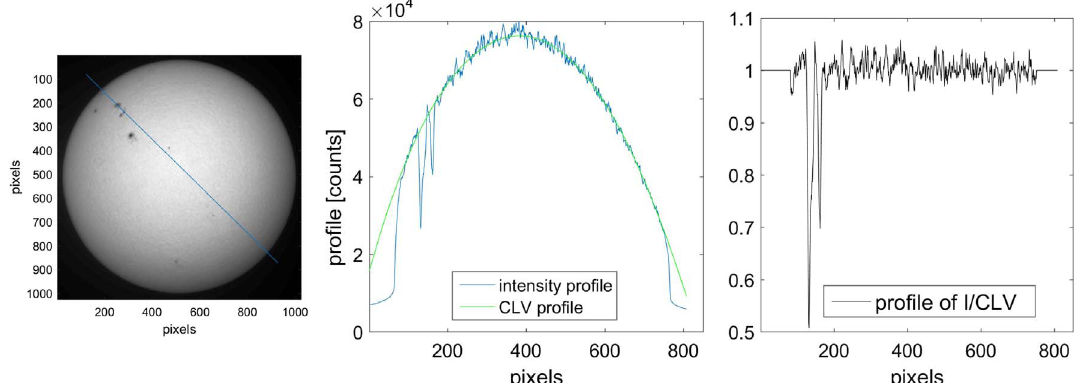
Fig. 6. Left panel : sample of a single intensity frame ( I R r þ component of the K channel), the continuous line represents the location to calculate the intensity pro fi les; central panel: the observed intensity pro fi le (continuous blue line) and the fi tted CLV (continuous green line) along the line reported in the left panel; right panel: the ratio between the observed intensity values of the image and the calculated CLV. The abscissas of the plots reported in the central and right panels are in pixels. The pro fi le range (displayed by dashed line in the central panel ) is 810 pixels, corresponding to 90% of the solar